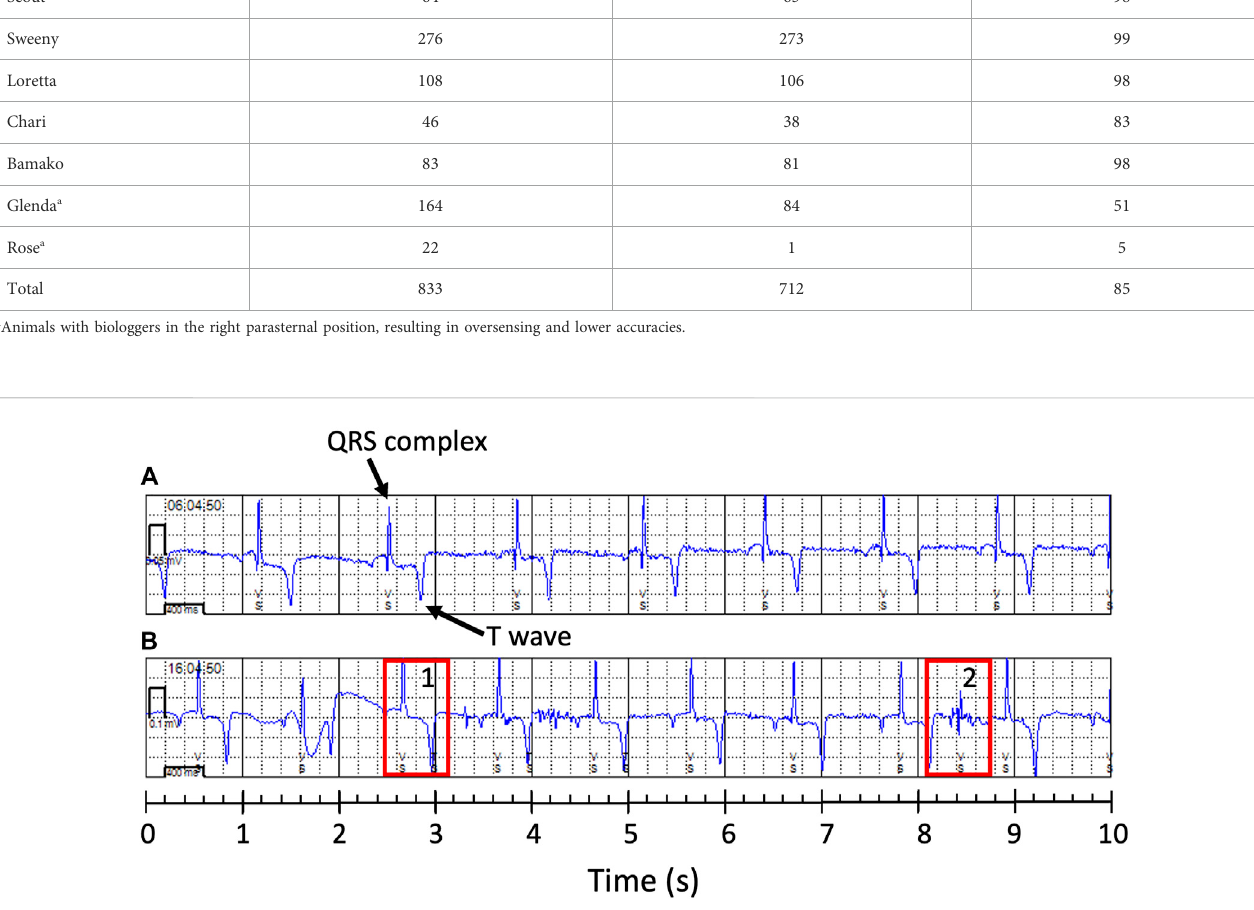
FIGURE 2 Examples of 10-s electrocardiogram (ECG) obtained from two female scimitar-horned-oryx with a heart monitor. Note that the ventricular sense (VS) marks correctly indicate the QRS complexes (arrow) in the accurate ECG in (A) (female “ Bamako ” ), but not in (B) (female “ Rose ” ). In (B) , the biologger was detecting T waves (rectangle 1) and electric noise (rectangle 2) as ventricular senses, increasing the number of ventricular senses to 14 instead of